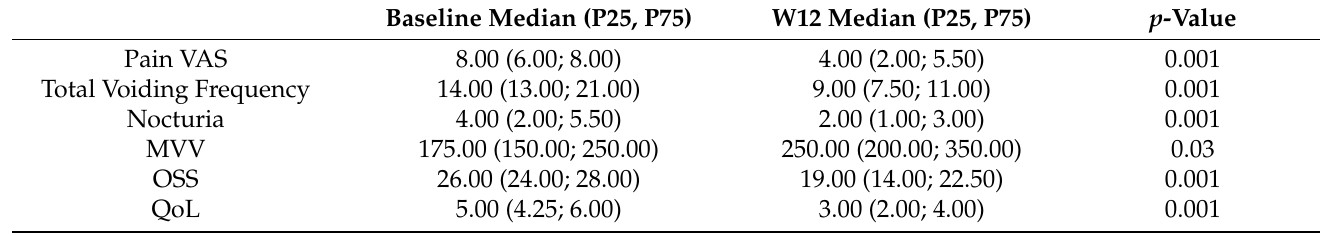
Table 1. Outcome comparison between baseline and 12w.